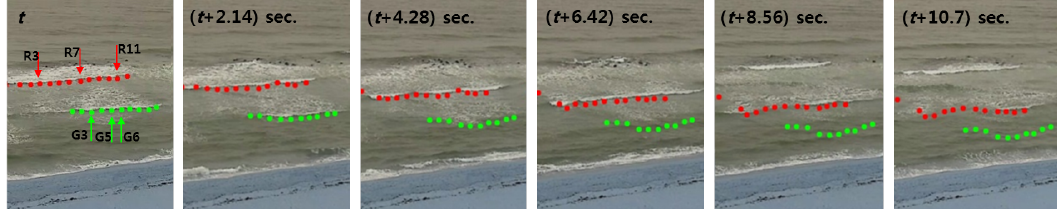
Figure 8. Visualization of wave-tracking by placing circles filled with red and green color on the image sequences of propagated breaking waves from one wave crest line from left to right with 2.14 s. time interval for 10.7 s. with 320